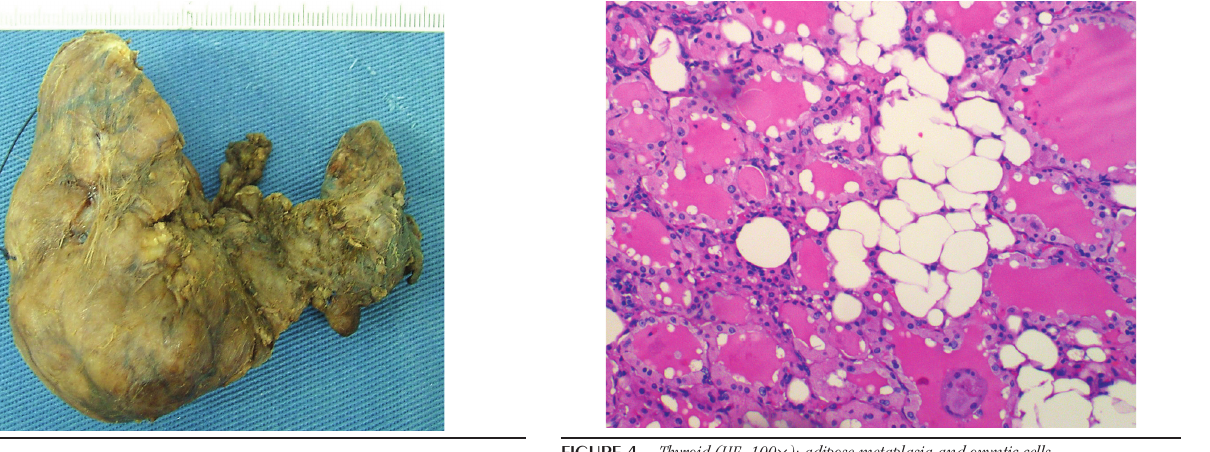
FigurE 1 − Enlarged thyroid with irregular appearance and dimensions of 6.8 × 6.5 × 3.3 cm, weighing 62 g